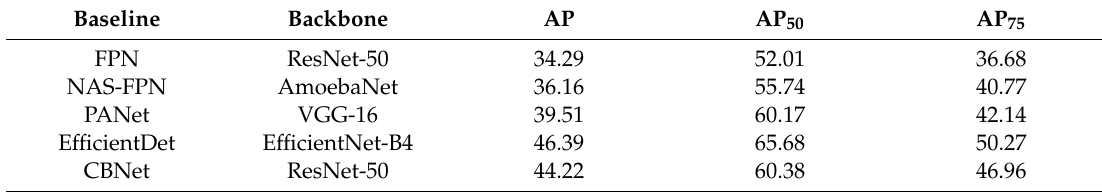
Table 3. Performance of the state-of-the-art FPN baselines on FBDF.